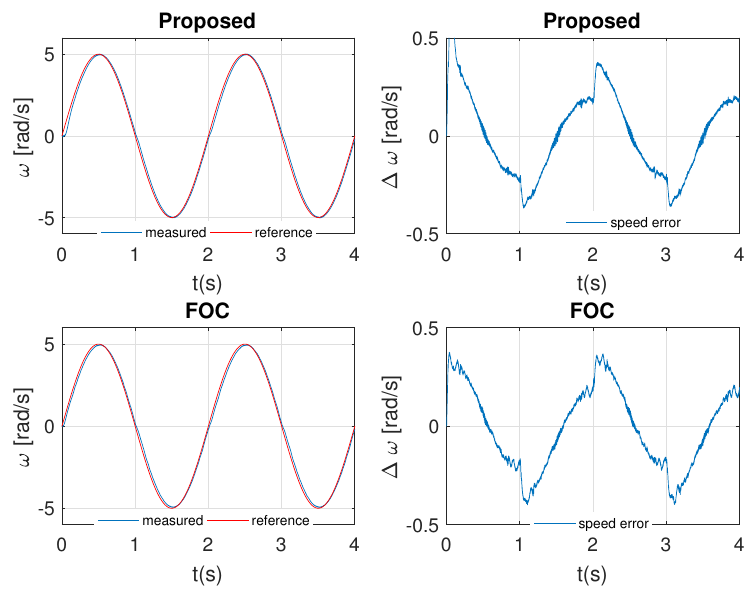
Figure 7. Performance comparison at low speed.